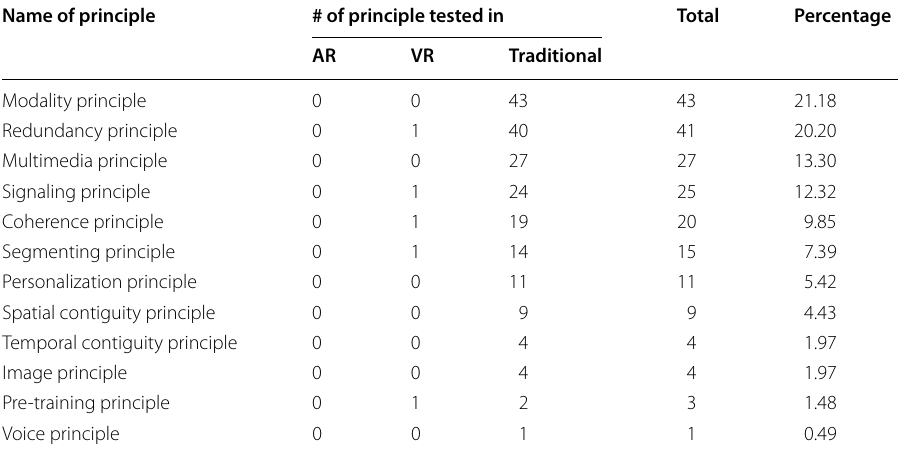
Table 9 Distribution of the multimedia learning principles based on the learning